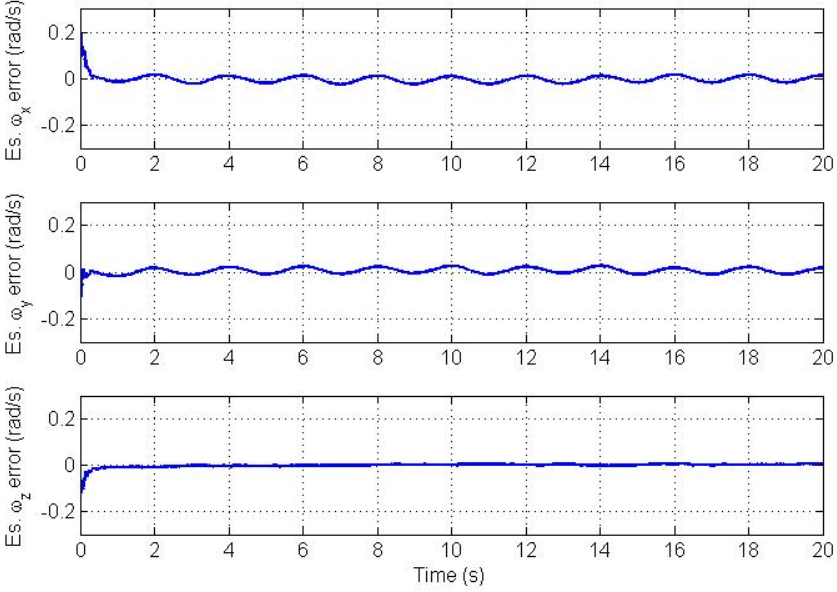
Figure 9. Angular velocity vector estimation errors for the reduced model.